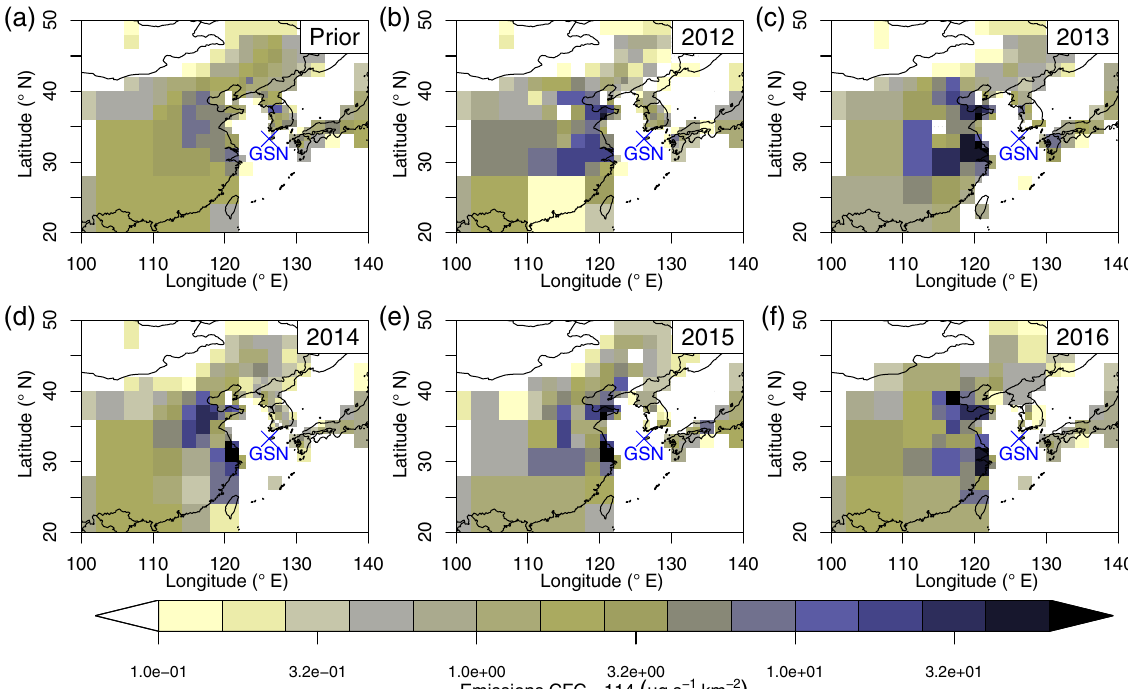
Figure 8. Emissions of (cid:54) CFC-114 from northeastern Asia as estimated with inverse modeling using the (cid:54) CFC-114 observations at Gosan (marked with a blue cross). (a) Common prior distribution; (b–f) posterior distribution for the years 2012 to